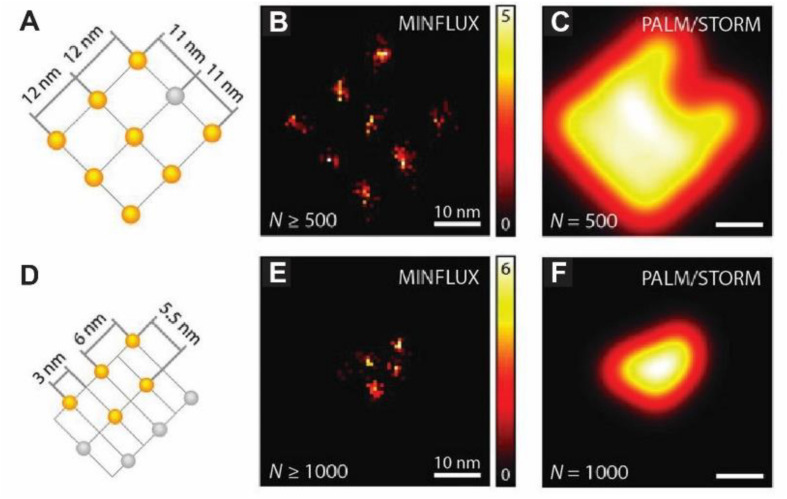
MINFLUX nanoscopy of labeled DNA origamis allows resolving molecules only 6 nm apart. (A) Arrangement of up to nine on-off switchable Alexa Fluor 647 fluorophores on the DNA origami with an 11 nm spacing (in gray are depicted those that remained in the off state throughout the measurement). (B) Spatial binning (bin size, 0.75 nm) of direct MINFLUX localizations renders a nanoscopic image of the origami from events yielding > 500 photons. (C) Simulated ideal PALM/STORM image of the origami using detections of 500 photons. (D–F) Similar representations as in (A–C) but for the smaller DNA origami depicted in (D). Events with under 100 detected photos were discarded. Adapted, with permission from Balzarotti et al. (2017).